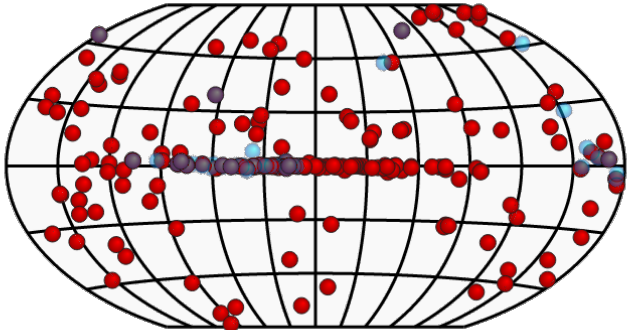
Figure 1. Overlay image in Galactic coordinates of the sources seen via the currently operating major IACT experiments (H.E.S.S., MAGIC, VERITAS, denoted in red) and via currently operating WCD and SA experiments (HAWC, LHAASO, in blue). Sources detected using both techniques are indicated in violet. Data obtained using the TeVCAT (http://tevcat2.uchicago.edu accessed on 18 October 2021)